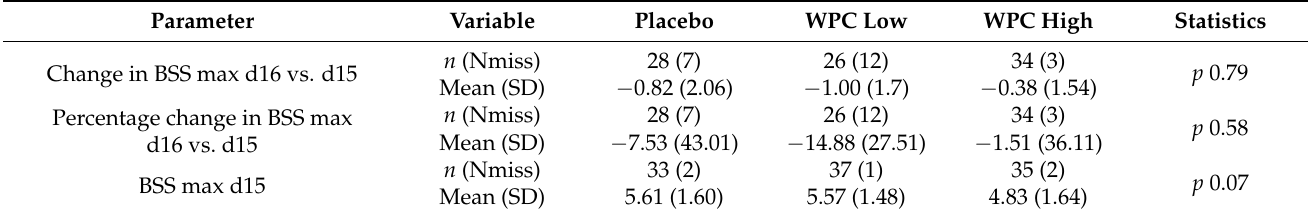
Table 5. Stool consistency as measured by Bristol Stool